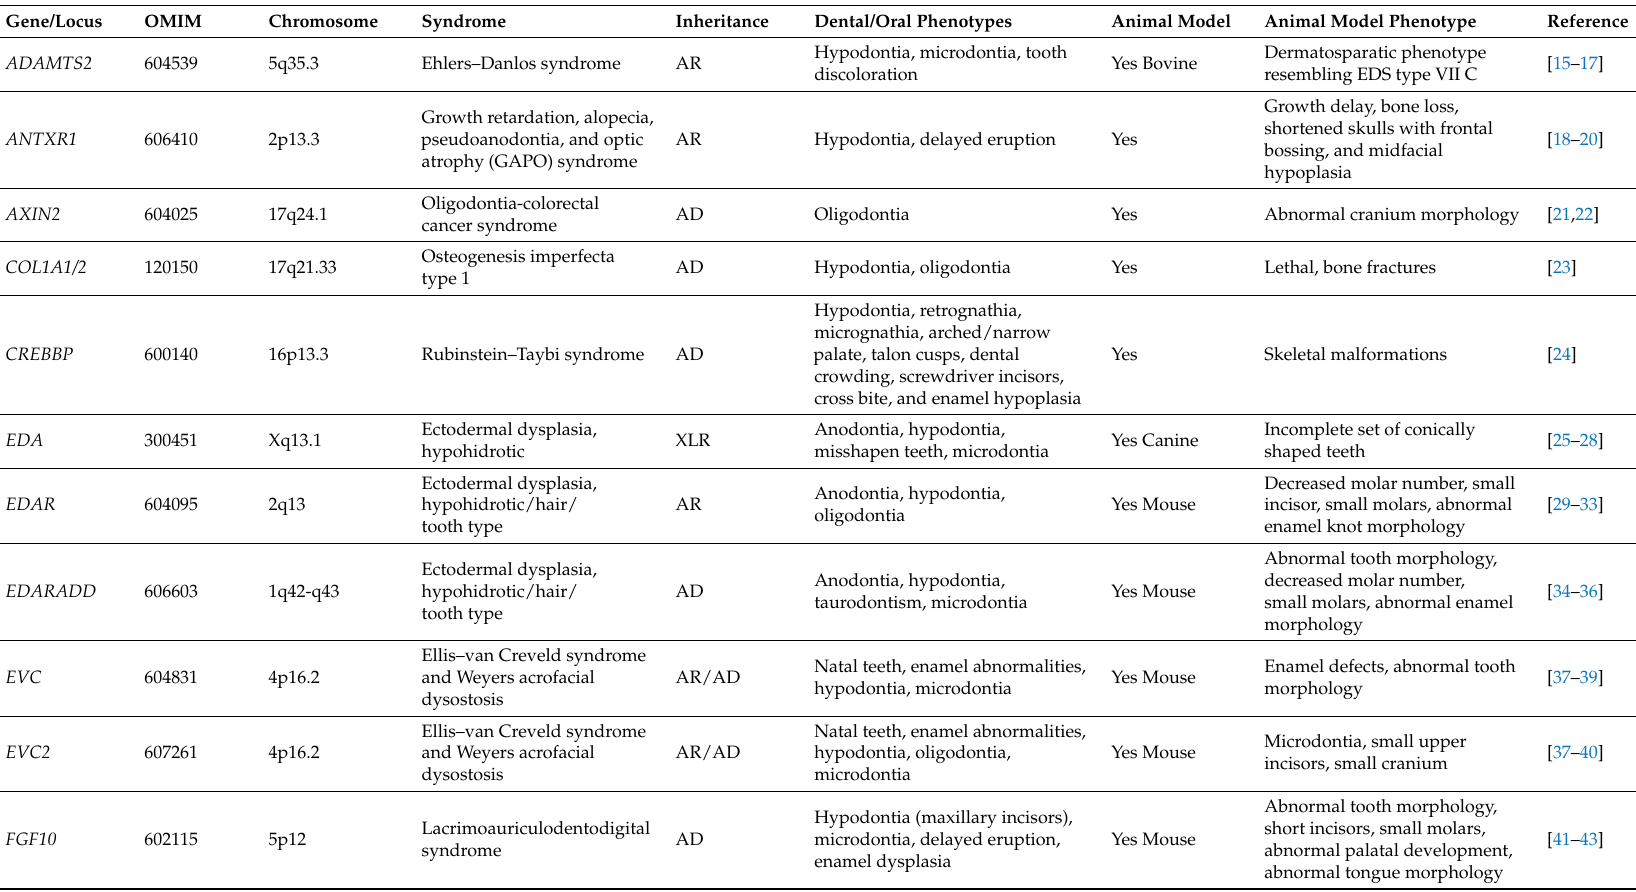
Table 1. Genes involved in syndromic tooth agenesis and associated